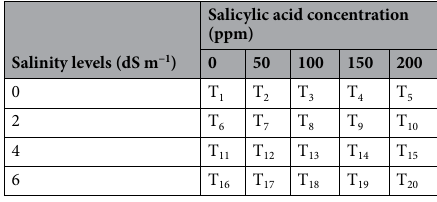
Table 1. Experimental